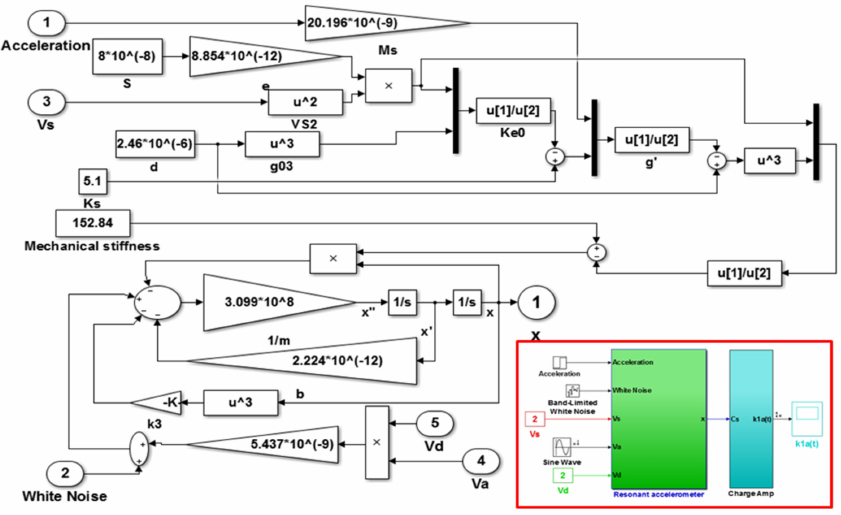
Figure 7. Numerical model of single-beam resonant